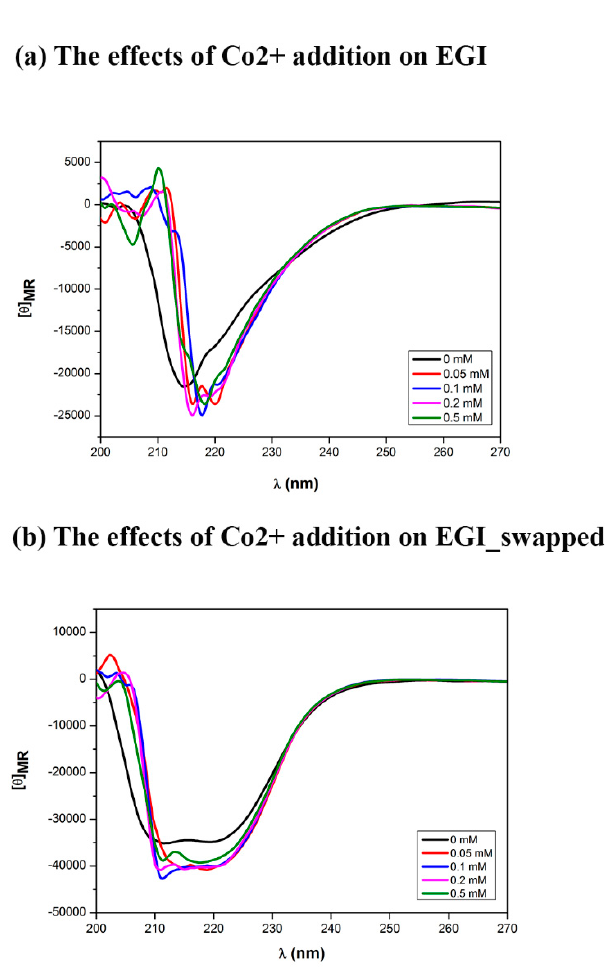
Figure 7. The effects of Co 2+ ion addition on secondary structures of EGI and EGI_swapped enzymes. Through Circular Dichroism, the differences in secondary structures of EGI ( a ) and EGI_swapped ( b ) upon Co 2+ ion addition have been captured within 210–220 nm and 215–230 nm, respectively. Protein samples were prepared in 50 mM sodium acetate buffer (pH 4.7) that was corrected for background at room temperature. All results are displayed in mean residue ellipticity ([ θ